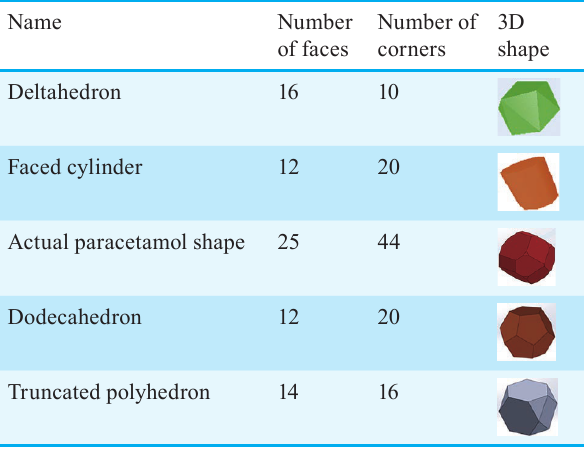
Table 1 Polyhedra used by Vivacqua et al. (2019) for simulat- ing faceted shapes. https://doi.org/10.1016/j.powtec.